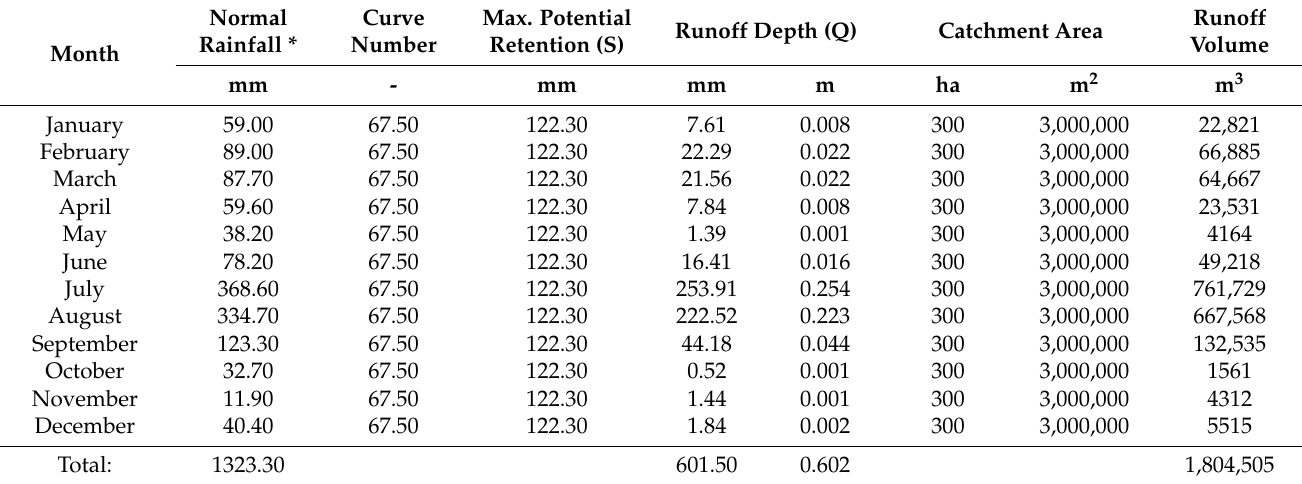
Table 1. Runoff Calculation at Fatima Jinnah Park (F9-Park) ICT.